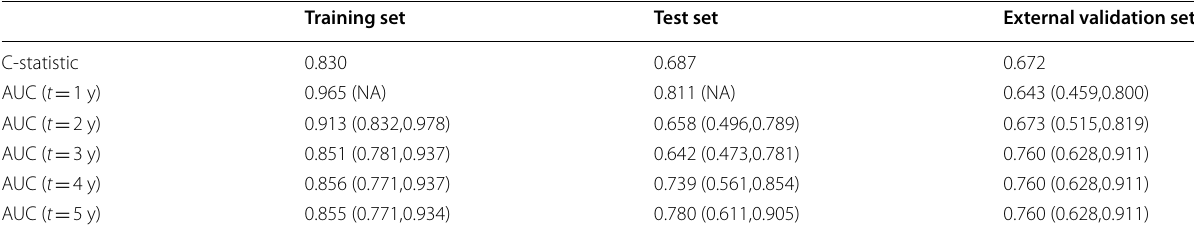
Table 5 Overall and time-dependent performance of a composite radiomic score at predicting lung cancer prognosis